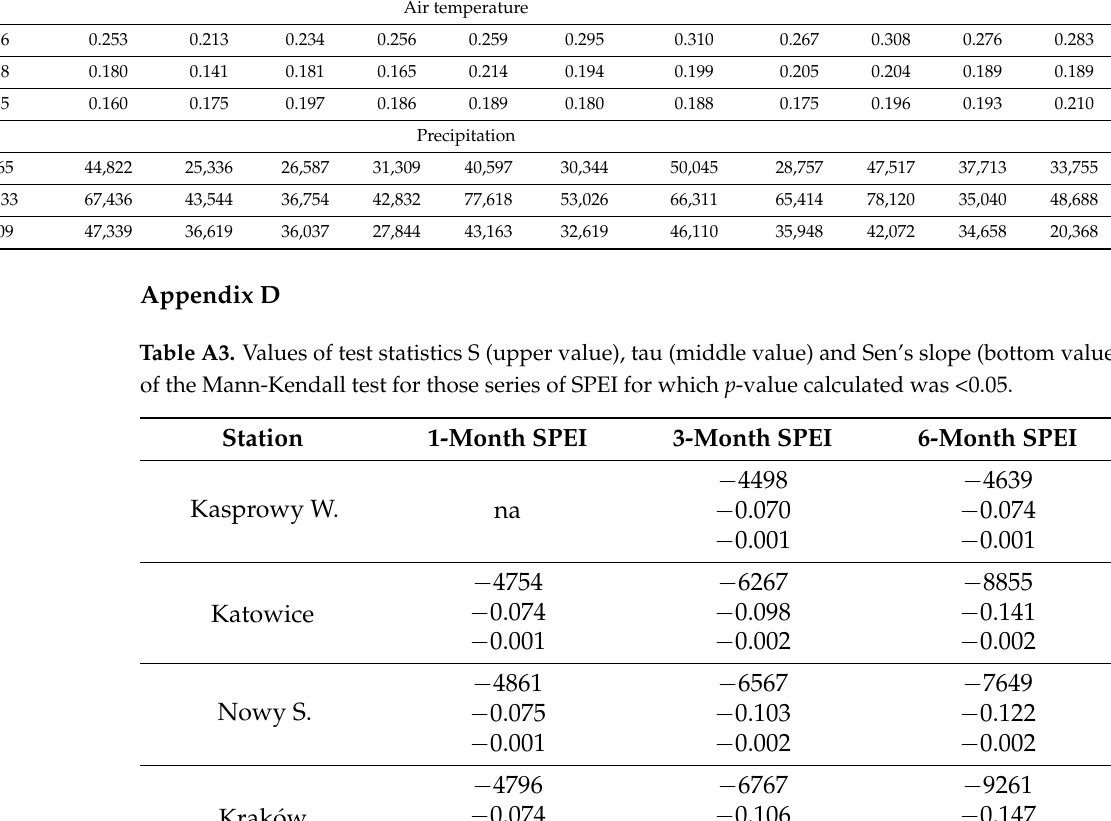
Table A2. Standard error for the mean annual air temperatures and precipitation totals shown in Figures 2 and 3. Decade Kasprowy W.